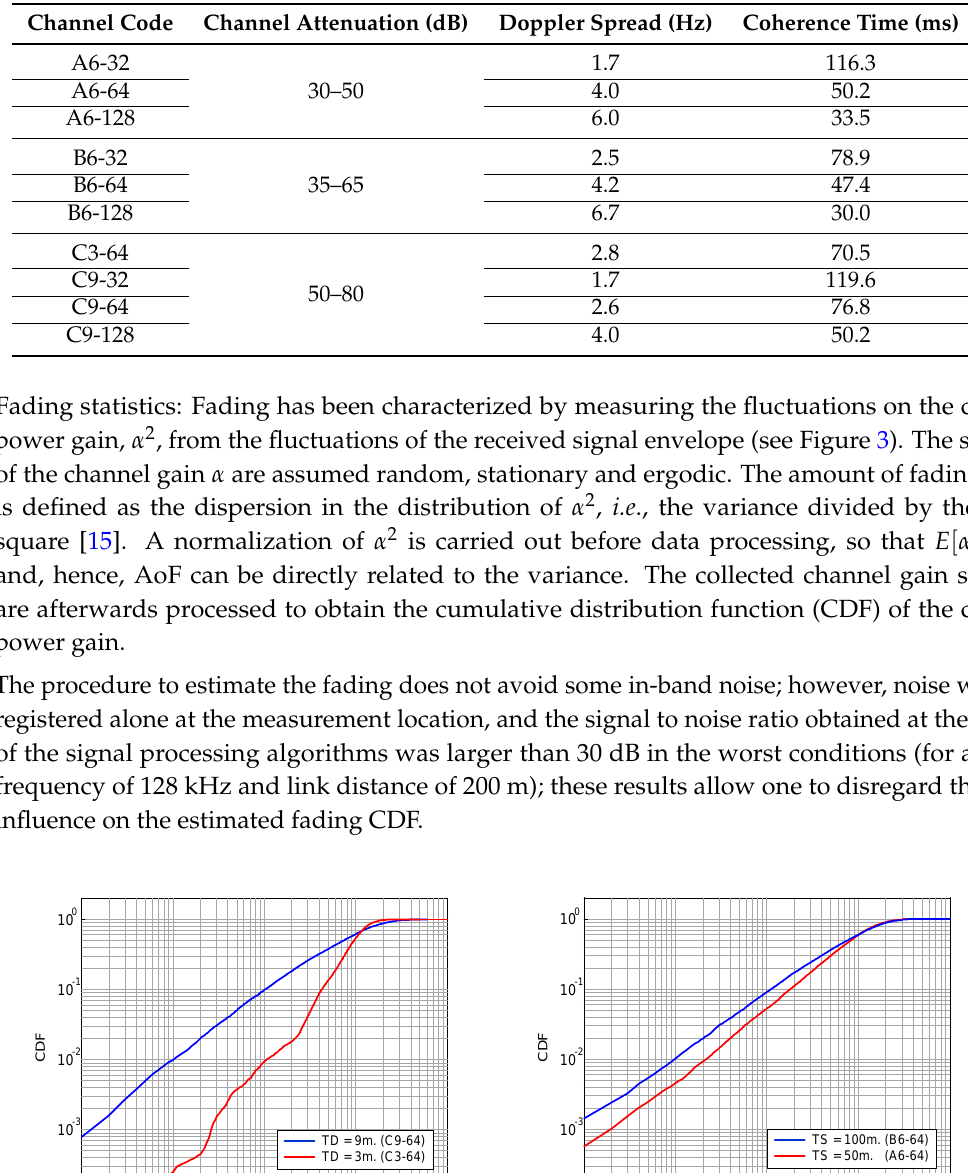
Table 2. Measured channel attenuation, Doppler spread and coherence time.